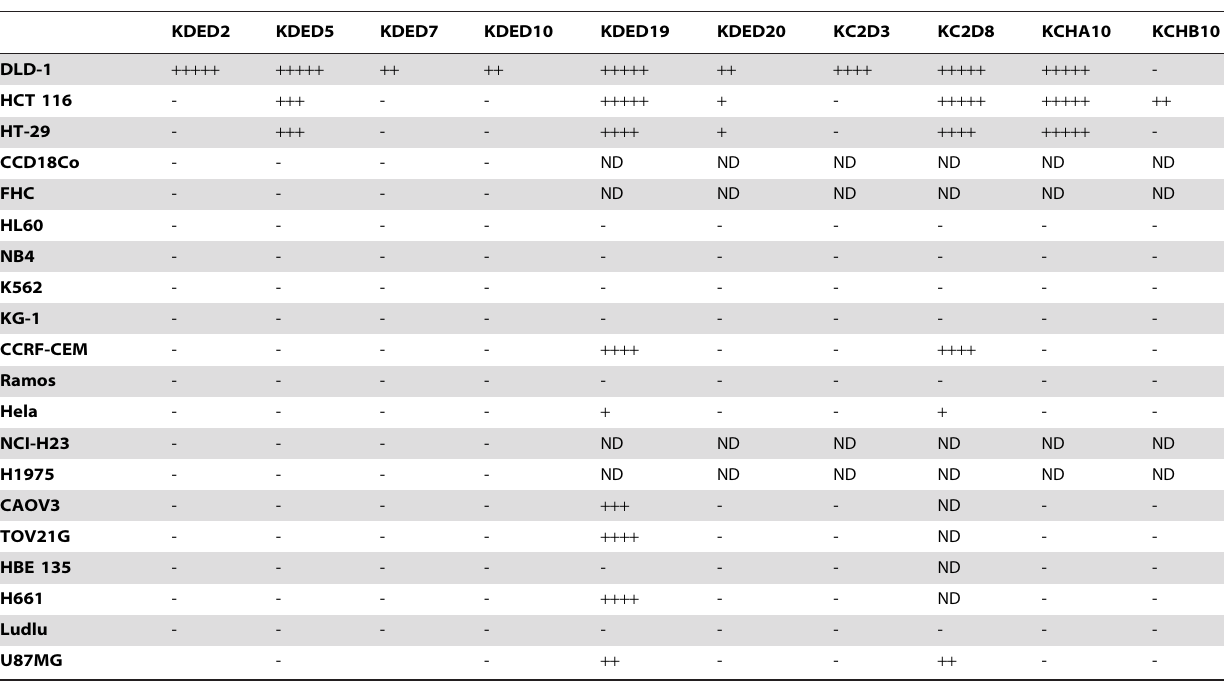
Table 3. Recognition of aptamers with different cancer cell